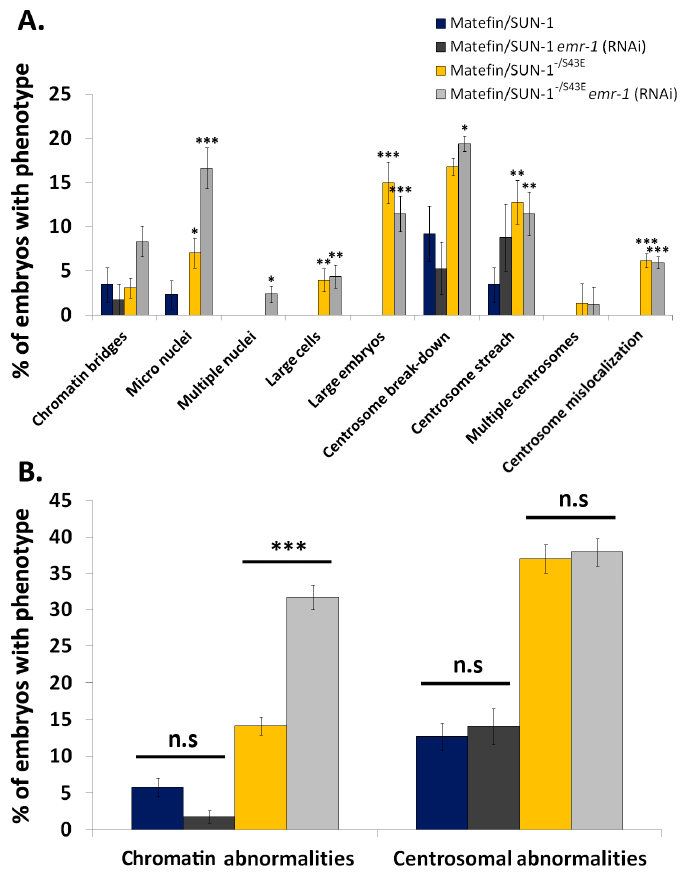
Figure 6. Emerin down regulation increases DNA abnormalities in a matefin/SUN ‐ 1 S43E embryos. DNA and centrosome abnormalities were analyzed in emr ‐ 1 (RNAi) embryos expressing wild type or S43E matefin/SUN ‐ 1. ( A ) percentage of embryos displaying the phenotypes: chromatin bridges, micro ‐ nuclei (S43E p value = 0.04; S43E emr ‐ 1 (RNAi) p value = 8.3 × 10 − 7 ), multiple nuclei (S43E emr ‐ 1 (RNAi) p value = 0.01), large cells (S43E p value = 0.002; S43E emr ‐ 1 (RNAi) p value = 0.0008), large embryos (S43E p value = 1.5 × 10 − 9 ; S43E emr ‐ 1 (RNAi) p value = 3.1 × 10 − 8 ), centrosome break ‐ down (S43E emr ‐ 1 (RNAi) p value = 0.01), centrosome stretch (S43E p value = 0.002; S43E emr ‐ 1 (RNAi) p value = 0.005), multiple centrosomes and centrosome mislocalization (S43E p value = 0.0002; S43E emr ‐ 1 (RNAi) p value = 8.8 × 10 − 5 ). P values as compared to wild type; ( B ) summary of results of chromatin and centrosome abnormalities from ( A ) the only significant result ( p value = 2.9 × 10 − 5 ) was observed in S43E emr ‐ 1 (RNAi). Error bars represent SEM. * p < 0.0 5, ** p < 0.005, *** p < 0.0005.